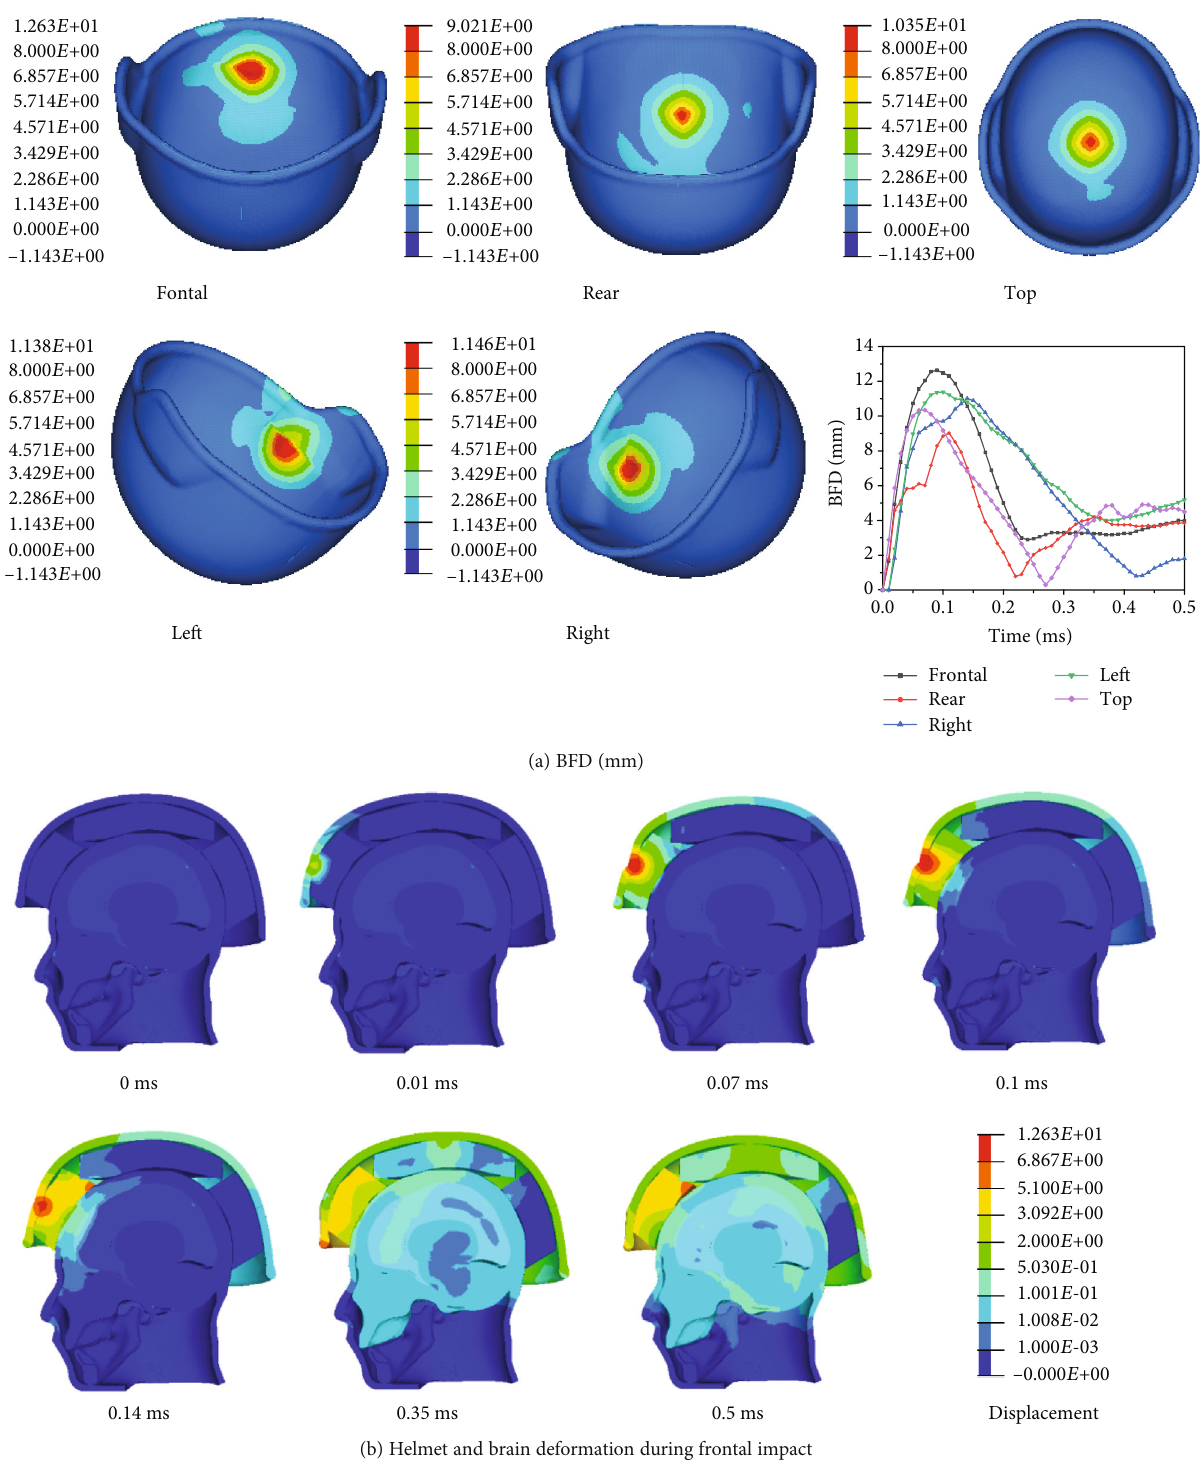
Figure 8: Helmet and brain